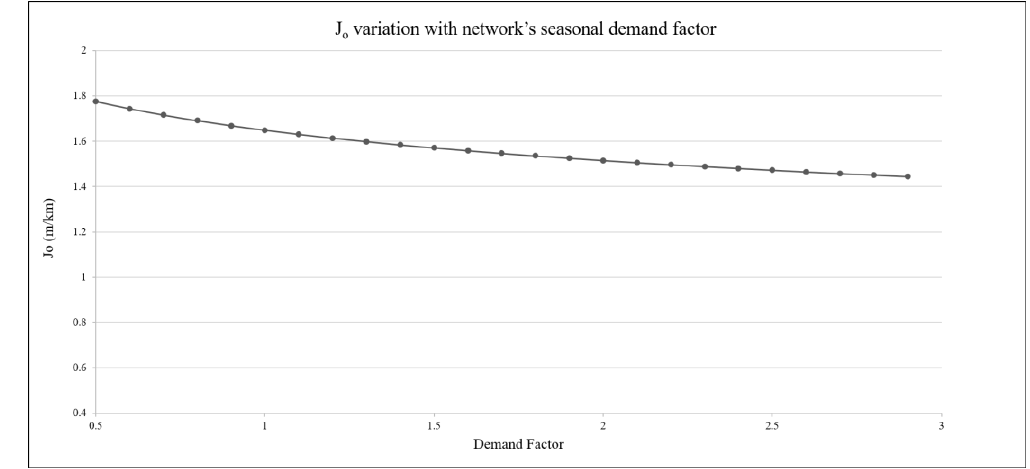
Figure 6. J 0 and total costs variation with network seasonal demand factor.